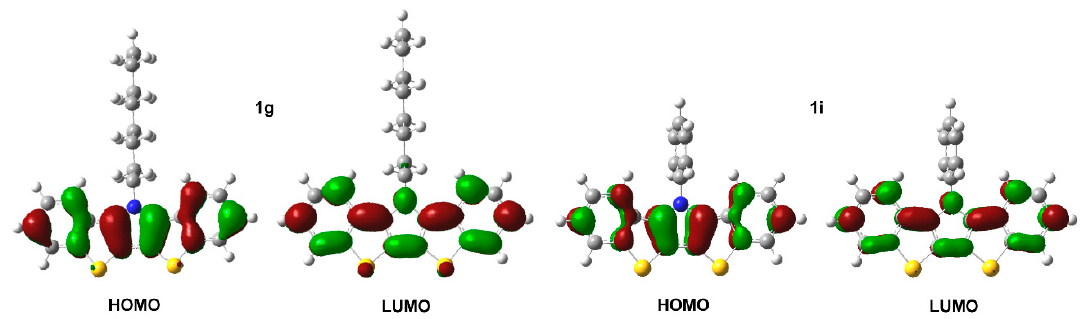
Figure 7. Electronic density contours, calculated at B3LYP/6 ‐ 31G(d,p) level, for the HOMO and LUMO frontier molecular orbitals of bis[1]benzothieno[3,2 ‐ b :2 ′ ,3 ′‐ d ]pyrroles 1g and 1i .